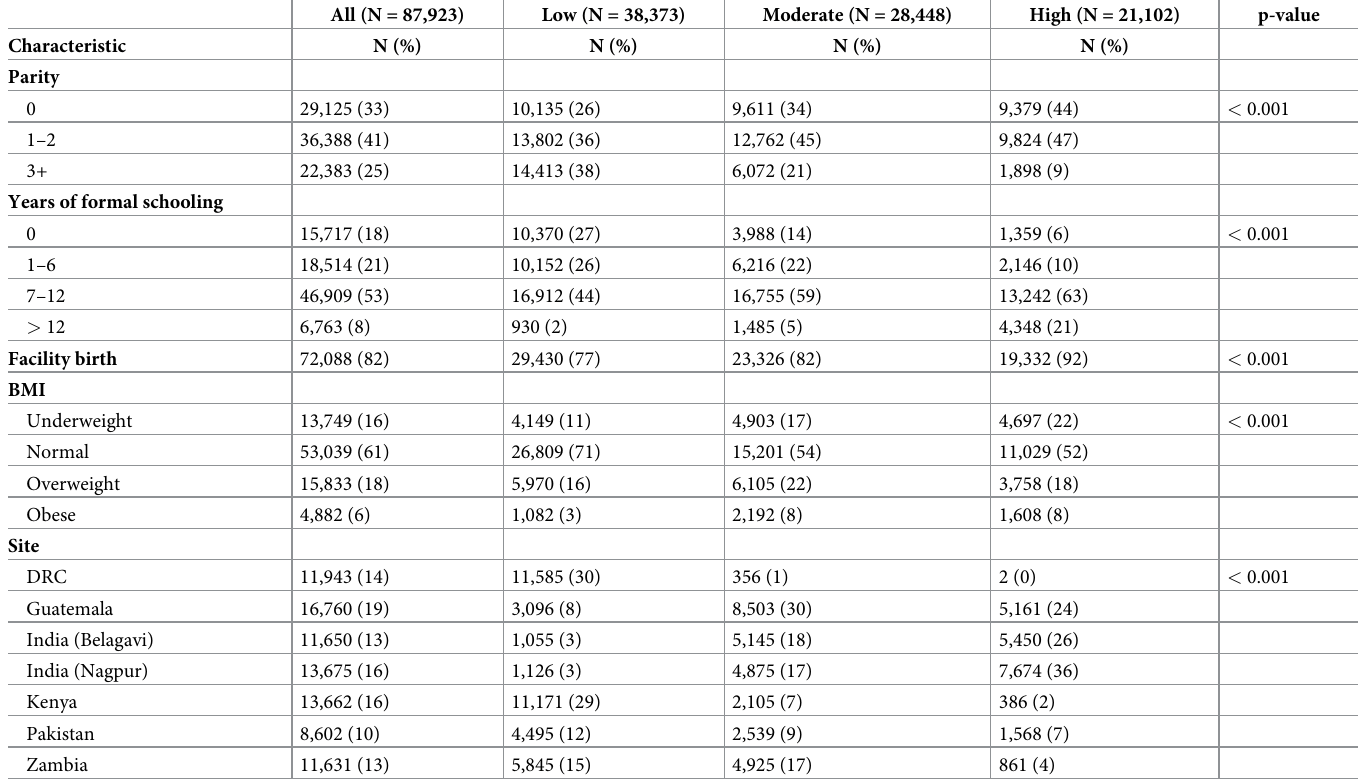
Table 1. Sample demographic characteristics by Socioeconomic Status